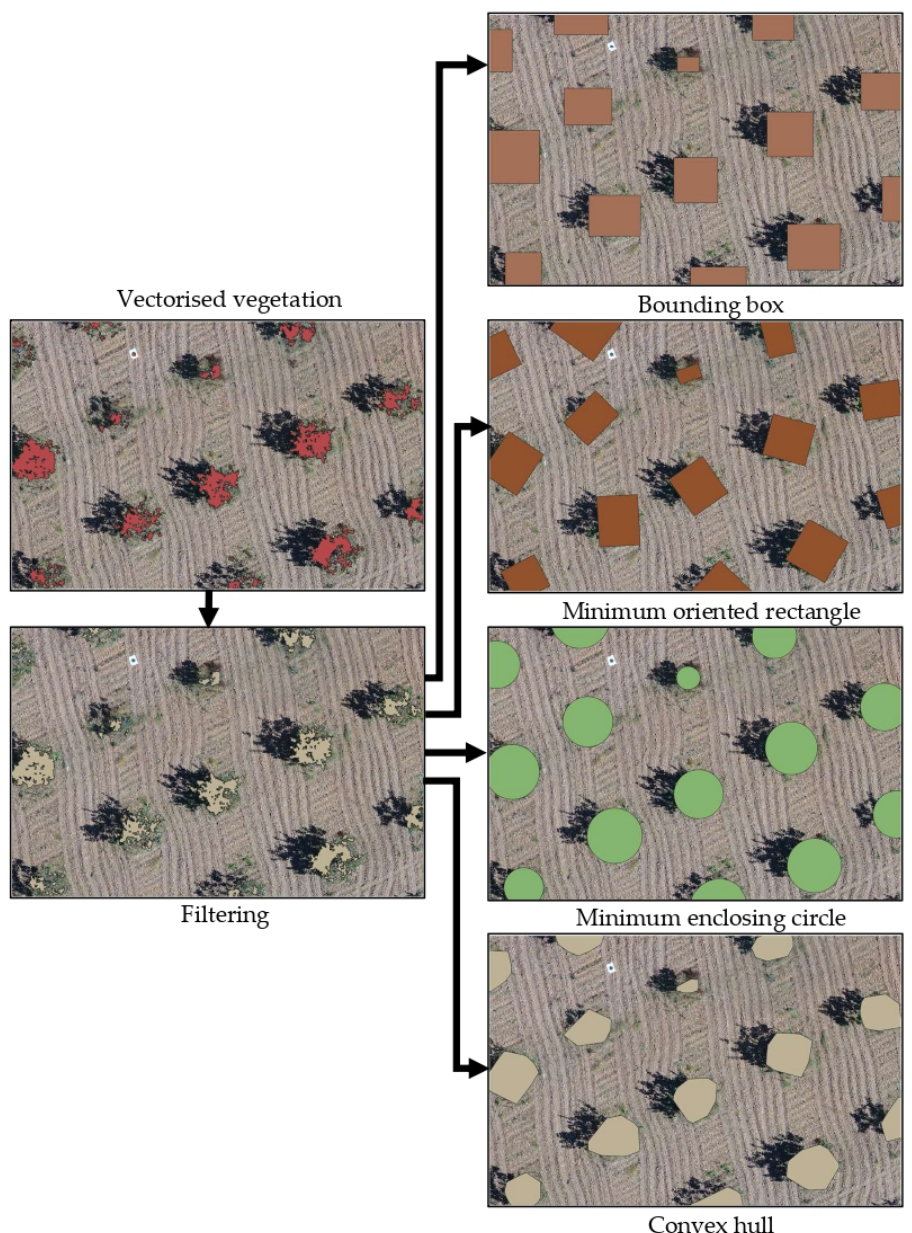
Figure 11. OBIA approach in the vegetation plane. Several types of geometries were used to envelop the area detected in the images (bounding boxes, oriented rectangles, enclosing circles and convex hulls).